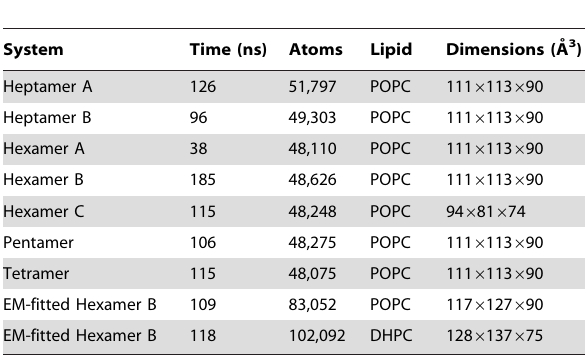
Table 4. List of the constructed p7 oligomers and MD simulations trajectory. Heptamer B and Hexamer B display lower total